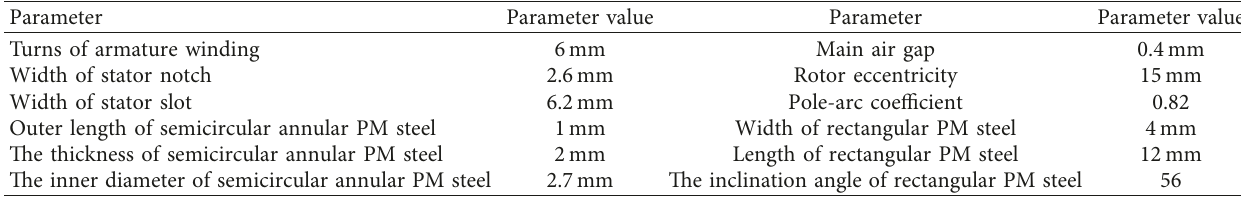
Figure 23: Variation diagrams of HEG voltage regulation rate and no-load voltage waveform distortion rate with different optimized groups. Table 4: Optimization parameters and their value range.